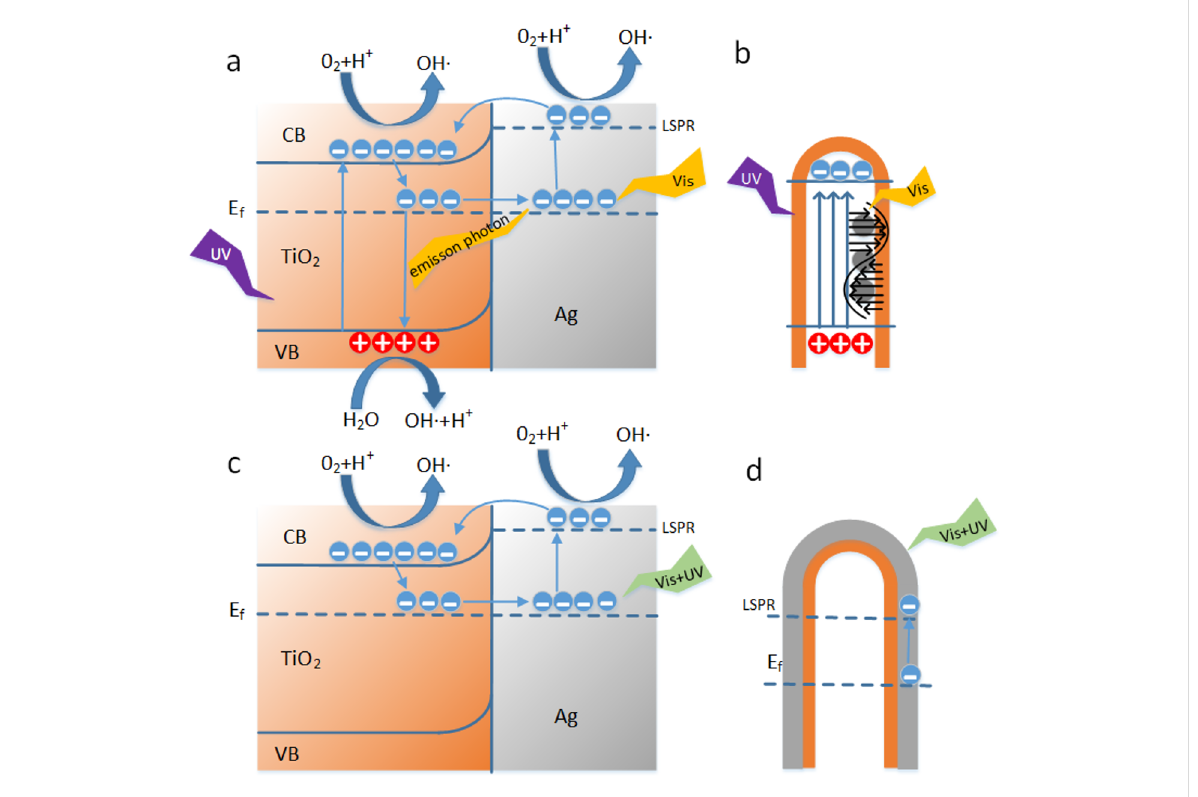
Figure 9: (a) Schematic diagram of electron–hole separation and energy conversion of Ag–TiO 2 structures under UV–vis illumination. b) AFT struc- ture light absorption diagram. c) Schematic diagram of energy conversion in the case of excessive Ag-coated TiO 2 . d) ACT structure light absorption